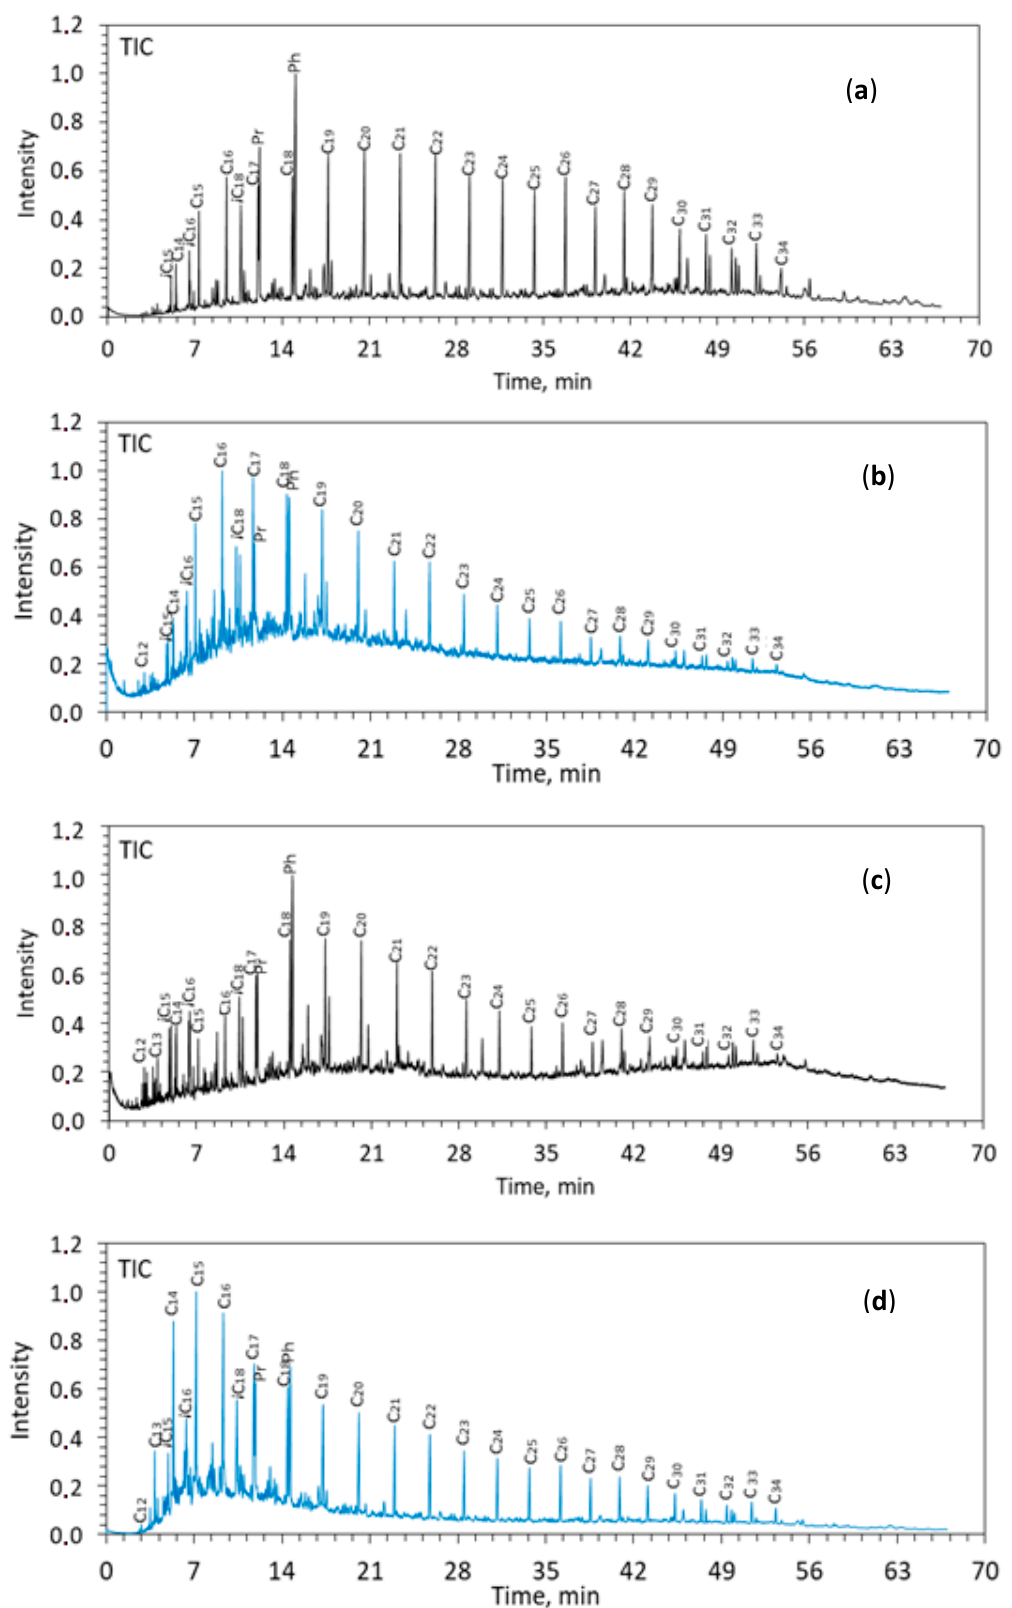
Figure 2. TIC of saturated fractions from the rocks of Zelenogorskaya and Berezovskaya areas before ( a , b ) and after ( c , d ) the experiments. C 12 –C 35 —the number of carbon atoms in n-alkanes. P r —pristane (C 19 ), Ph—phytane (C 20 ).